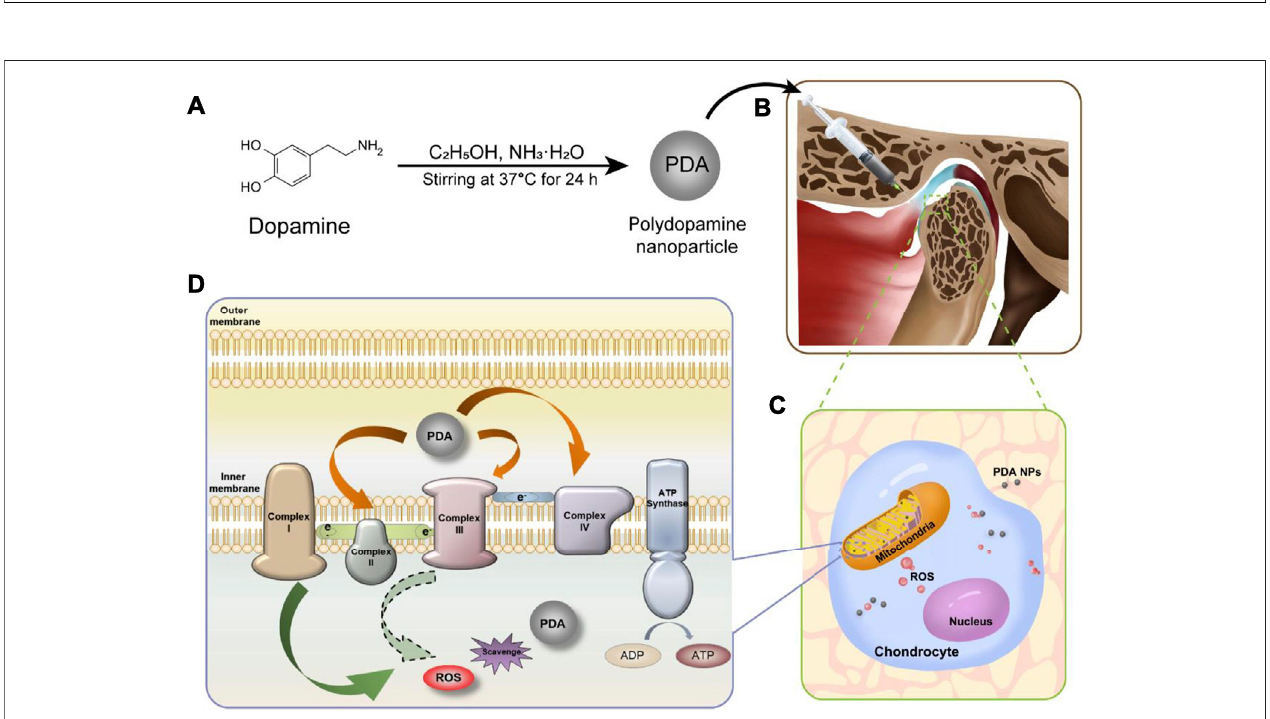
Frontiers in Chemistry |